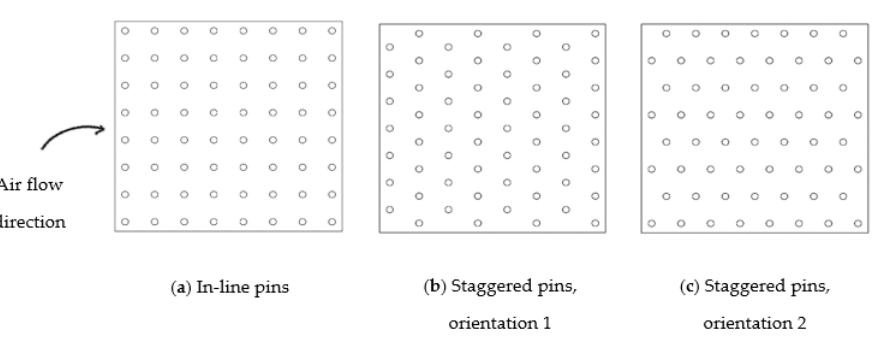
Figure 11. Best fin heat sink (among those studied).